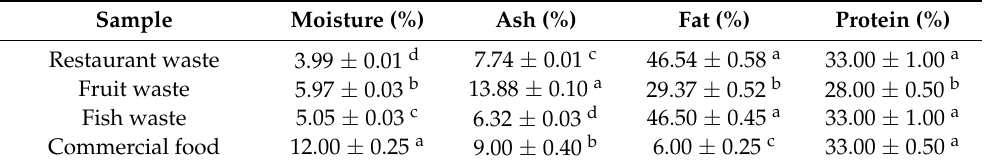
Table 4. Nutritional composition (%) of BSF pre-pupae meal fed with different organic